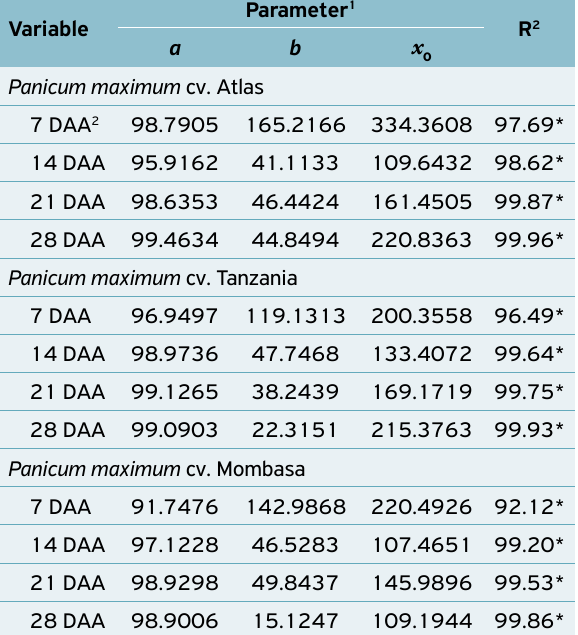
Table 1. Parameters of the regression equations obtained by fitting the sigmoidal model and coefficient of determination (R 2 ) applied to the means of phytotoxicity percentage of Panicum maximum cv. Atlas, P. maximum cv. Tanzania, and P. maximum cv. Mombasa at 7, 14, 21, and 28 days after application as a function of glyphosate doses (0, 54, 108, 270, 378, 540, 756, and 1,080 g a.e. ha -1 ) associated with atrazine (1,200 g a.i. ha -1 ). Parameter 1 Variable R 2 a b x